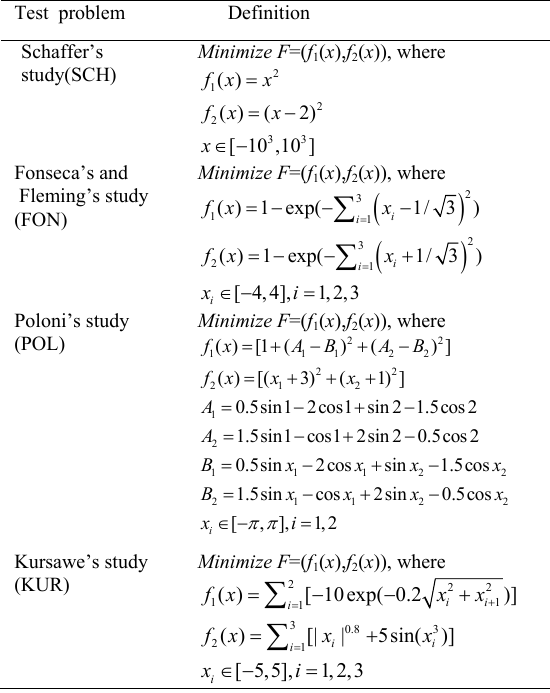
/ Ns : size of the swarm; MaxIter : maximum member